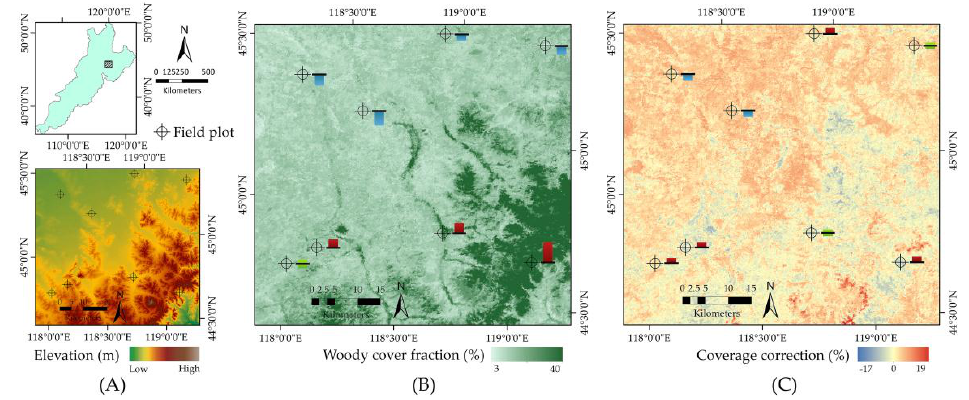
Figure 8. Example of estimation improvement using models with combined input datasets. ( A ) Locations of field observation sites in various terrains; ( B ) the spectral data-derived estimation of woody cover; ( C ) the correction of estimation calculated through the optimal model (with combined input sets) results minus the values shown in ( B ). The model result overestimates,